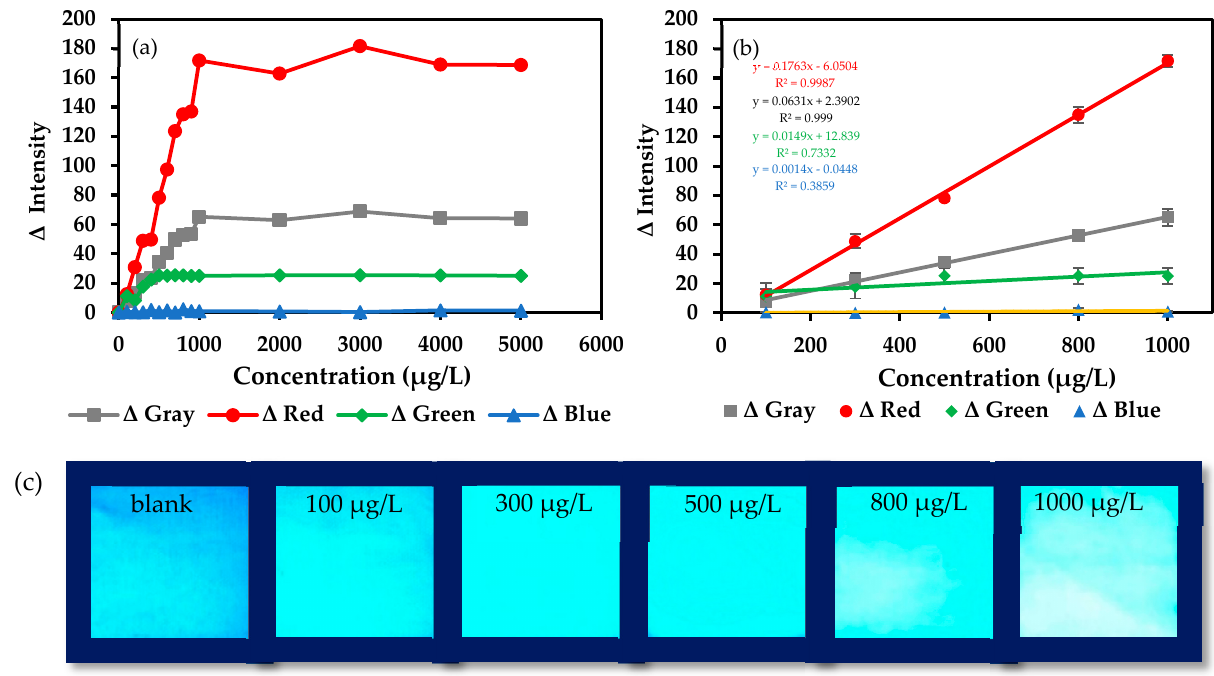
Figure 6. ( a ) Graph plotted between Δ Intensity and the concentrations of MT ranging from 0 to 5000 μ g/L, ( b ) calibration curves showing linearity between Δ Intensity and the concentration of MT, and ( c ) the optical fluorescence images of the MIPs@EDA-CDs/CF after MT detection at different concentrations in the detection box using the proposed method.